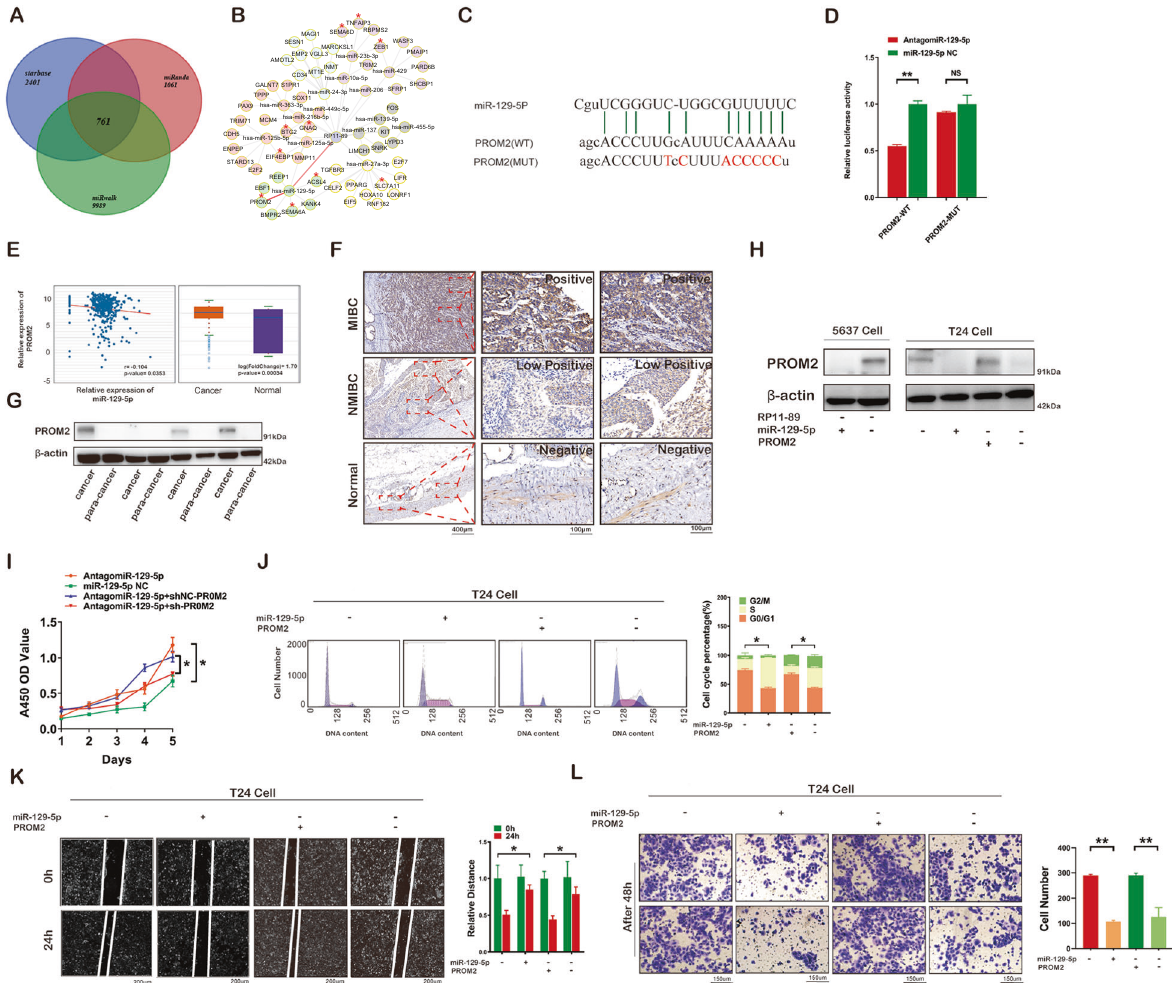
Fig. 5 miR-129-5p suppresses bladder cancer via targeting PROM2. A Venn diagram shows target genes of miR-129-5p predicted by the starBase, miRanda and miRwalk databases. B The lncRNA-miRNA-mRNA regulatory networks show the association between RP11-89 and ferroptosis. *ferroptosis-related genes. C The binding sites between miR-129-5p and WT/MUT of 3 ′ UTR of PROM2. D Dual luciferase assay showed that miR-129-5p down-regulated PROM2. E The upregulated expression of PROM2 in BLCA tissues and the negative correlation between miR-129-5p and PROM2 expression in TCGA database. F Immunohistochemistry analysis of PROM2 in normal tissues, NMIBC tissues and MIBC tissues assessed by Image J. G Western blot of the expression of PROM2 in four paired BLCA tissues. H Western blot con fi rmed the expression of PROM2 in each group transfected as indicated. I CCK-8 assay indicated that knockdown of PROM2 restored cell proliferation in miR-129-5p inhibited cells. J Cell cycle analysis indicated the percentage of G2/M phase, S phase and G0/G1 phase cells in each group transfected as indicated. K Scratch test showed the migration capacities of cells transfected as indicated. L Transwell assay revealed that knockdown of PROM2 restored the migration ability in miR-129-5p inhibited cells. Results are presented as mean ± SD. * P < 0.05; ** P < 0.01, *** P < 0.001, **** P < 0.0001. Data were obtained from at least three independent